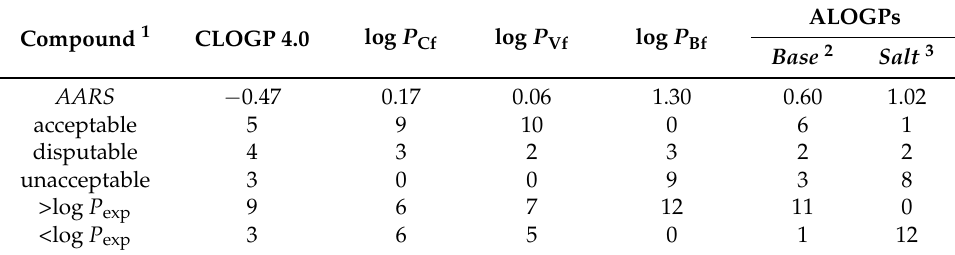
Table 3. Comparative validity check of employed calculation